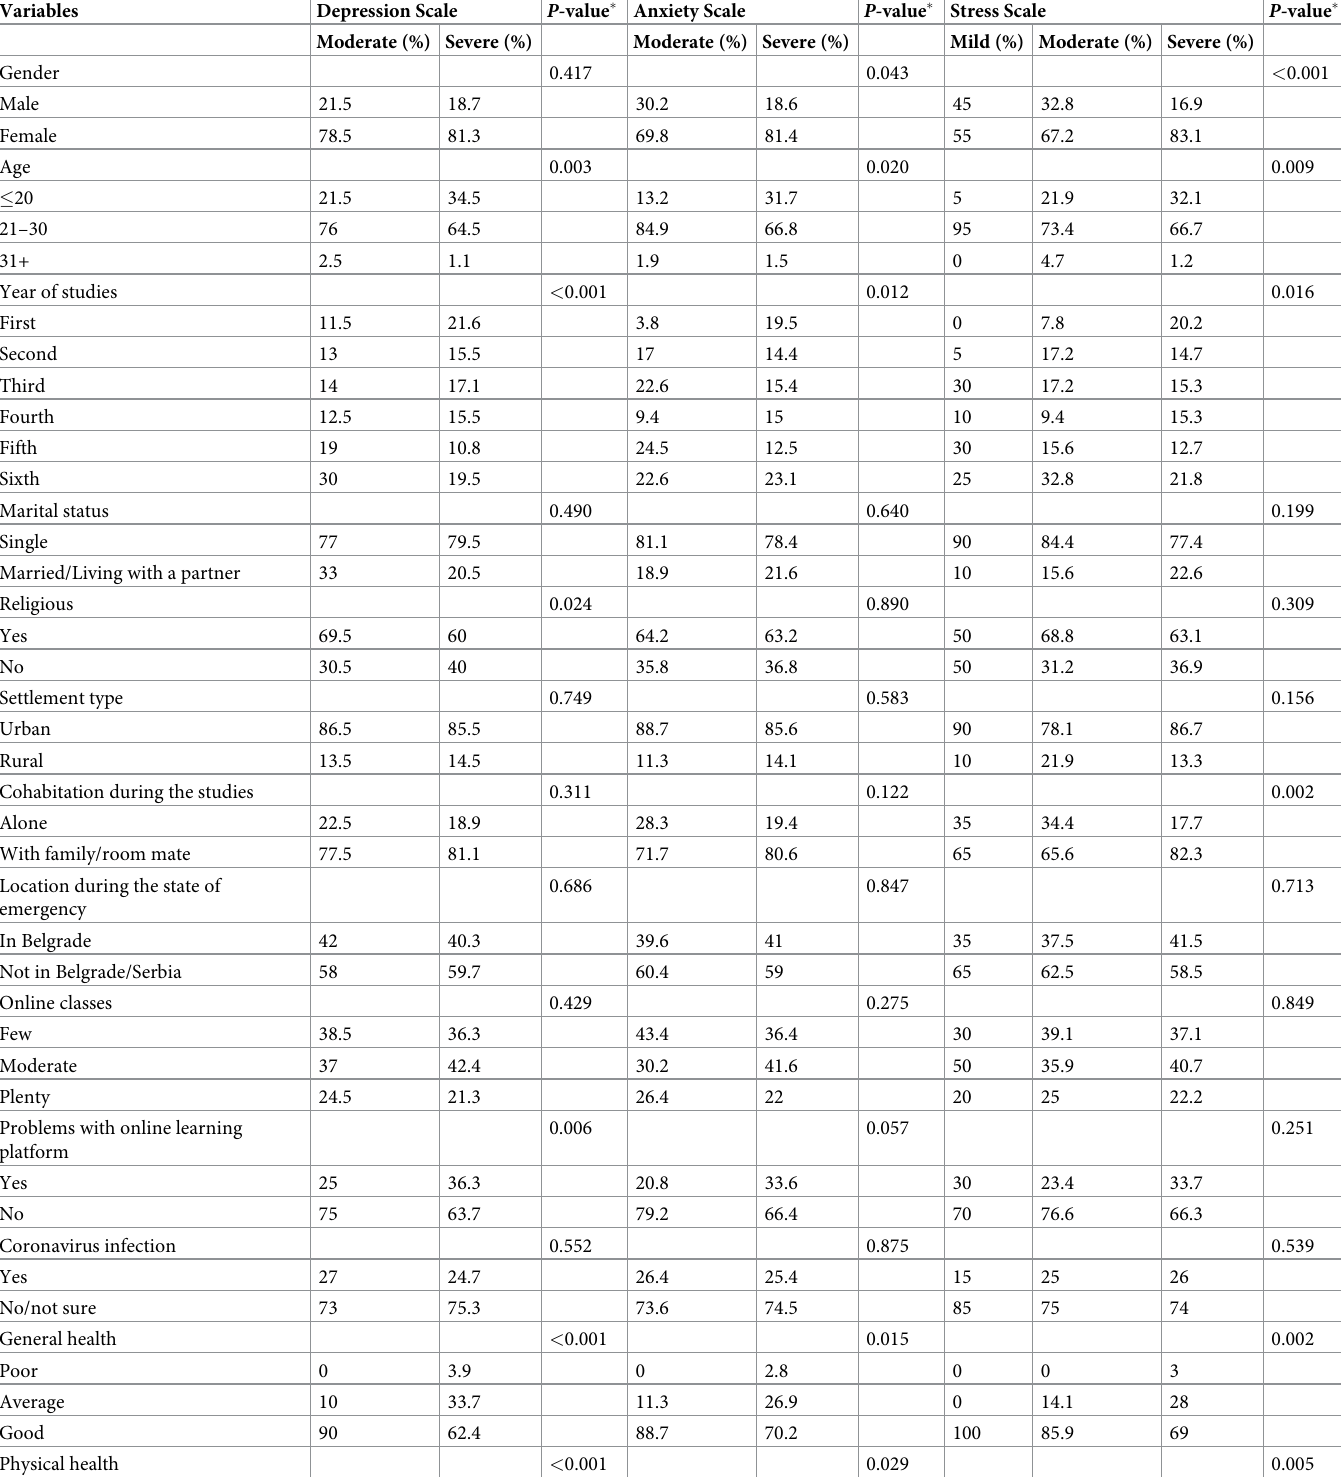
Table 2. Distribution of self-assessed depression, anxiety and stress, as well as their differences in relation to students demographic variables, their medical studies and health status during the coronavirus epidemic.